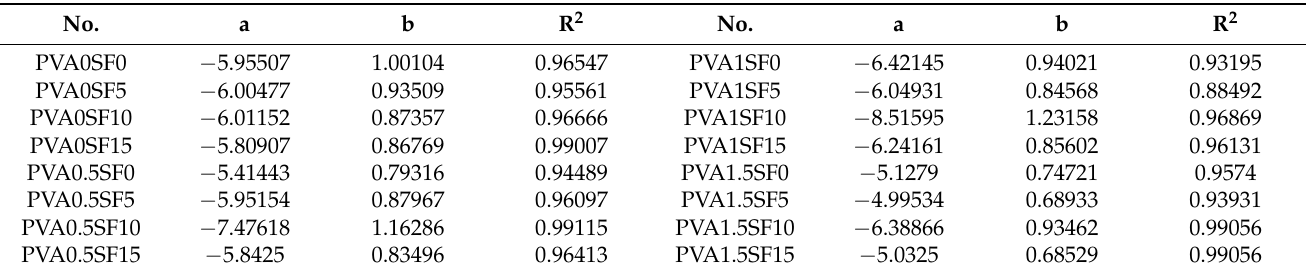
Table 4. Weibull distribution linear regression